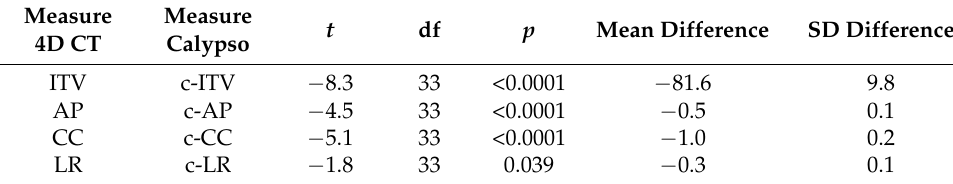
Table 2. Paired samples t -test.